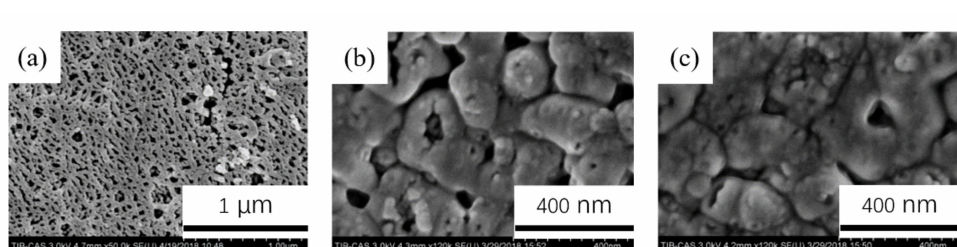
Figure 12. SEM images of 2024 anodic oxide films at different anodic oxidation voltages: ( a ) 30 V, ( b ) 120 V and ( c ) 160 V.